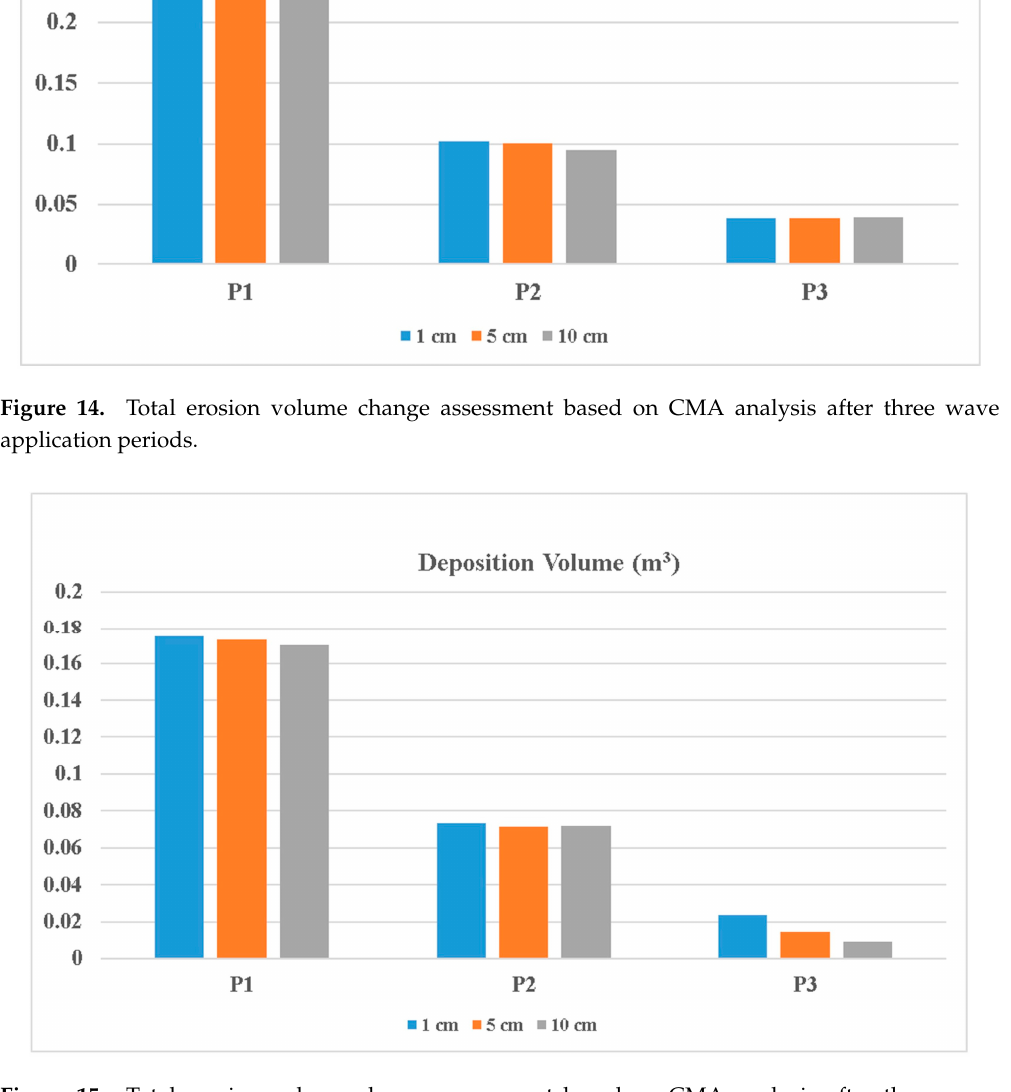
Figure 15. Total erosion volume change assessment based on CMA analysis after three wave application periods.